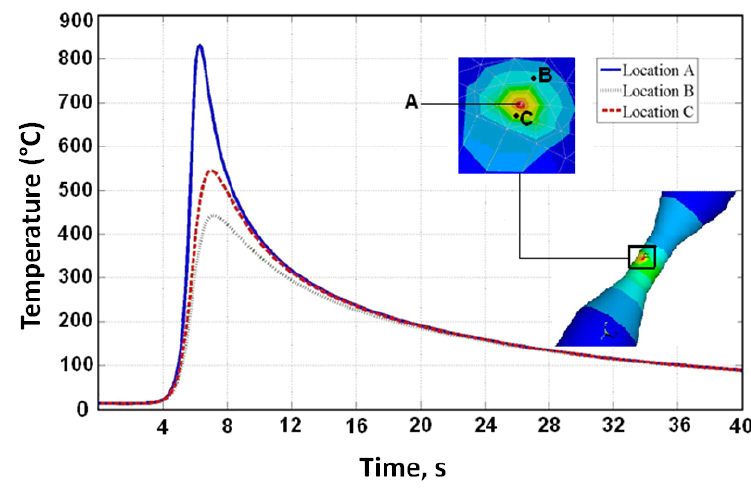
Figure 10. Calculated temperatures for nodes A, B, and C over time. Figure 10 . Calculated temperatures for nodes A, B, and C over time. Figure 10 . Calculated temperatures for nodes A, B, and C over time.